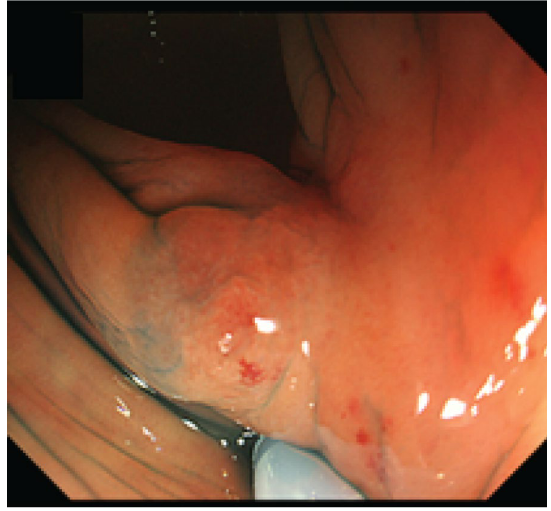
Fig. 3 Second examination findings of colonoscopy. Colonoscopy was performed 2 months after the initial one for preoperative localization, and revealed tumor shrinkage to a diameter of 15 mm and a shift to type 0–IIc